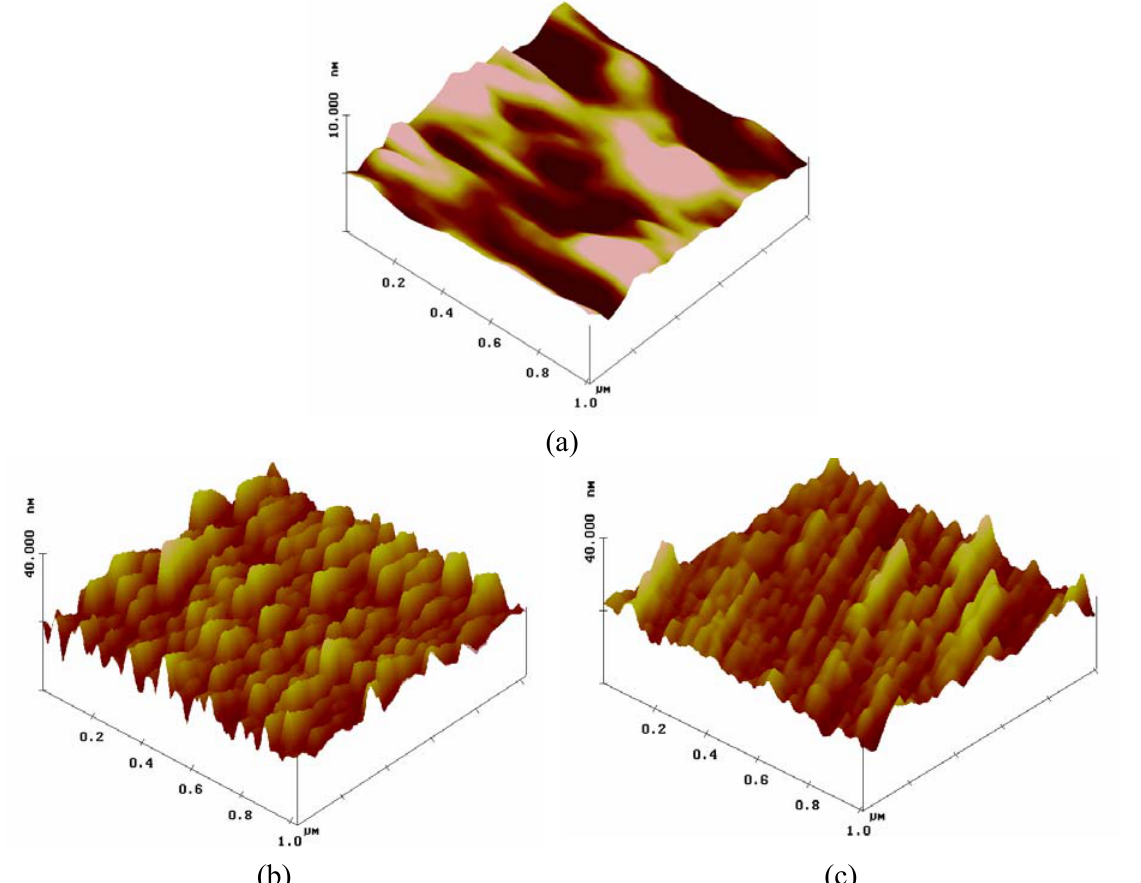
Figure 3. AFM images of ( a ) unmodified PI, ( b ) PI modified with the succinimidyl ester of AFB (PI-AFB) and ( c ) PI coated with